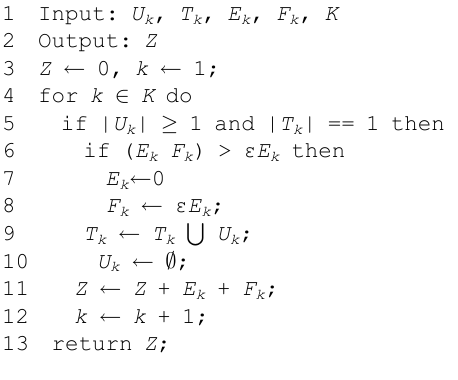
Algorithm 3: Terminal optimization ();